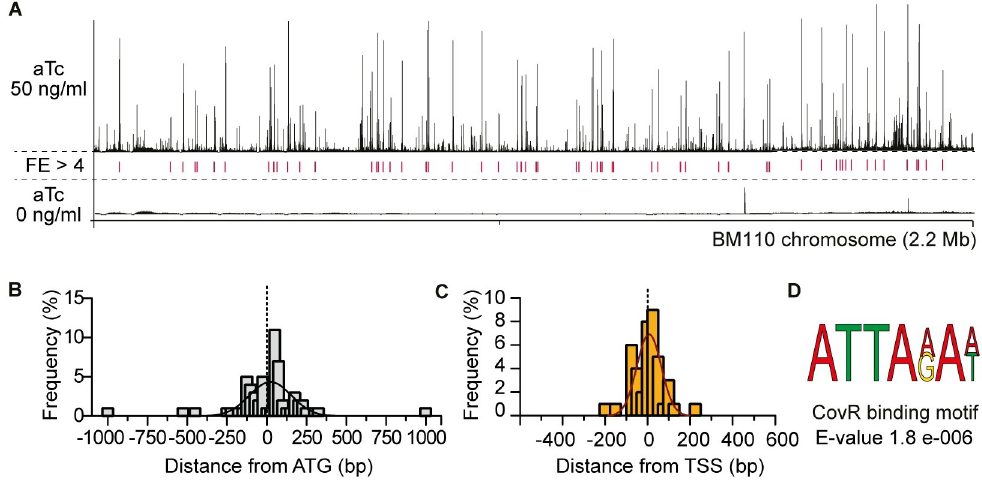
Fig 2. Whole-genome CovR binding on the BM110 genome. (A) ChIP-seq profile of CovR on the BM110 chromosome. Sequence reads were mapped on the chromosome after induction of the epitope-tagged FLAG-CovR with 50 (upper panel) or 0 ng/ml (bottom panel) anhydrotetracycline (aTc) in a Δ covR mutant. Peak height represents the mean coverage at each base pair of two independent ChIP-seq experiments. Loci with significant fold enrichment (FE > 4, IDR < 0.05) are indicated by red lines. (B) Distribution of the distance between each CovR binding peak and the nearest start codon. Distances were calculated from the summit of each CovR peak. The histogram represents the proportion of CovR binding sites (N = 62) in each sliding window of 25 bp, with an additional fitting curve. (C) Distribution of the distance between each CovR binding peak and the nearest transcriptional start site. Calculated as for (B). (D) Predicted CovR binding consensus sequence. Sequence enrichment in the 62 CovR binding loci (100 bp each) identified with the DREME software [86].